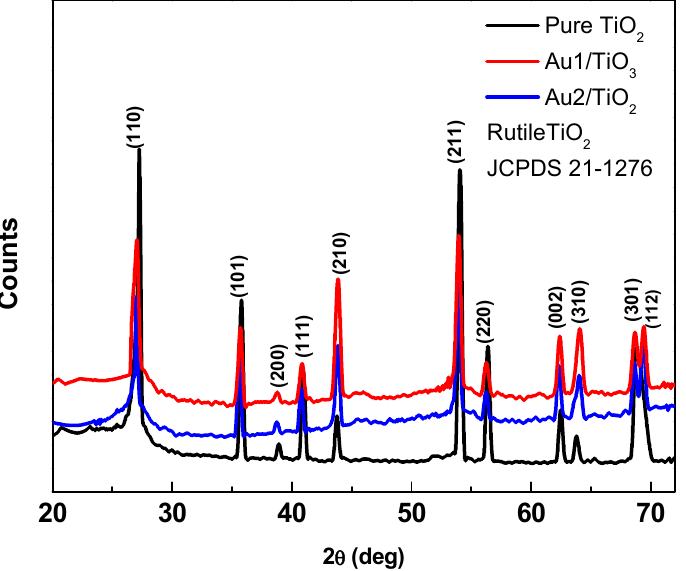
Figure 3. XRD patterns for the as-prepared pure TiO 2 , Au1/TiO 2 , and Au2/TiO 2 .